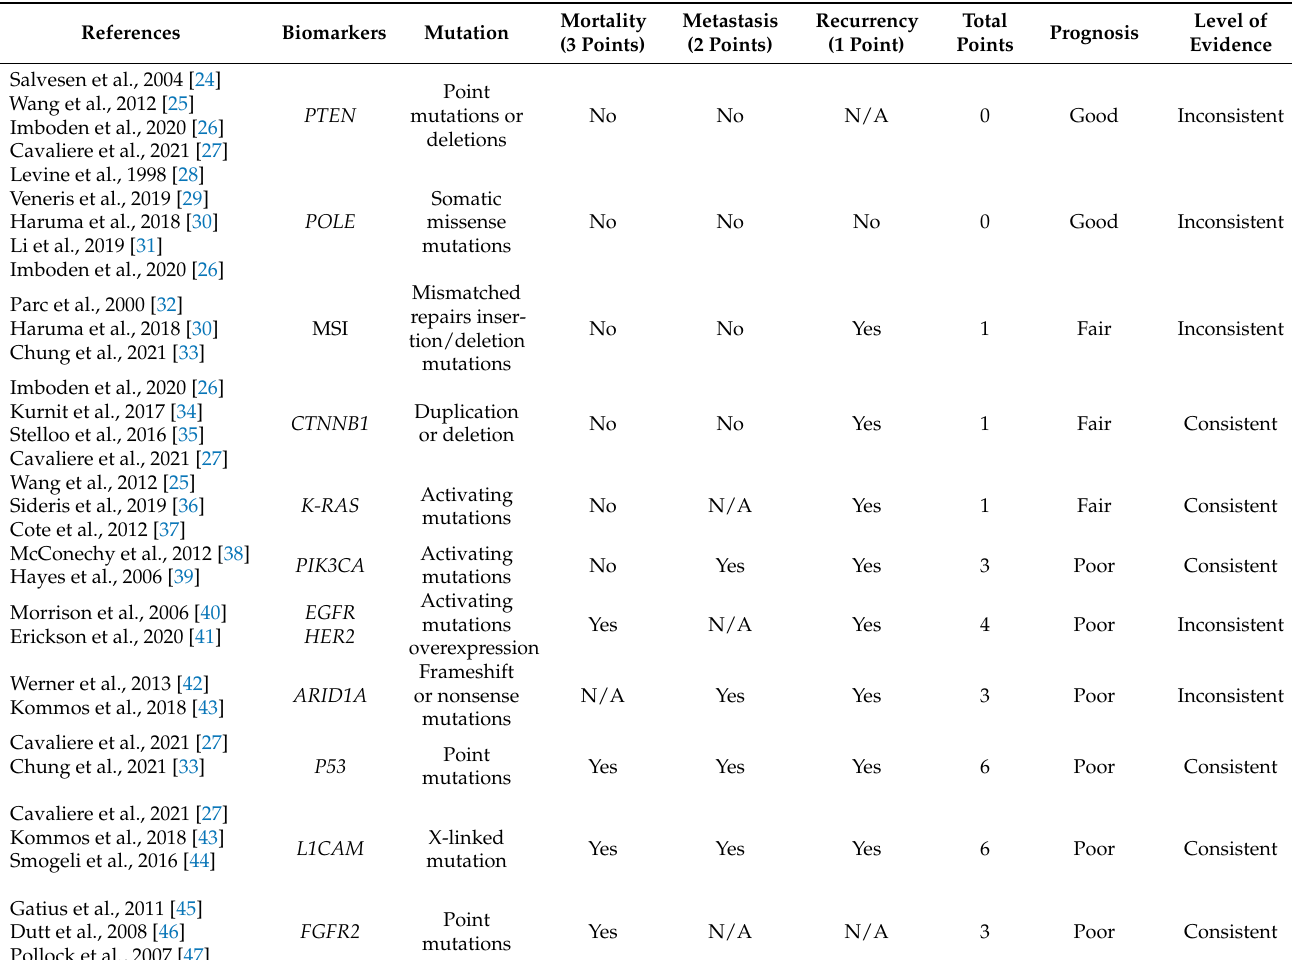
Table 1. Detailed analysis of prognostic factors in early stage endometrial cancer